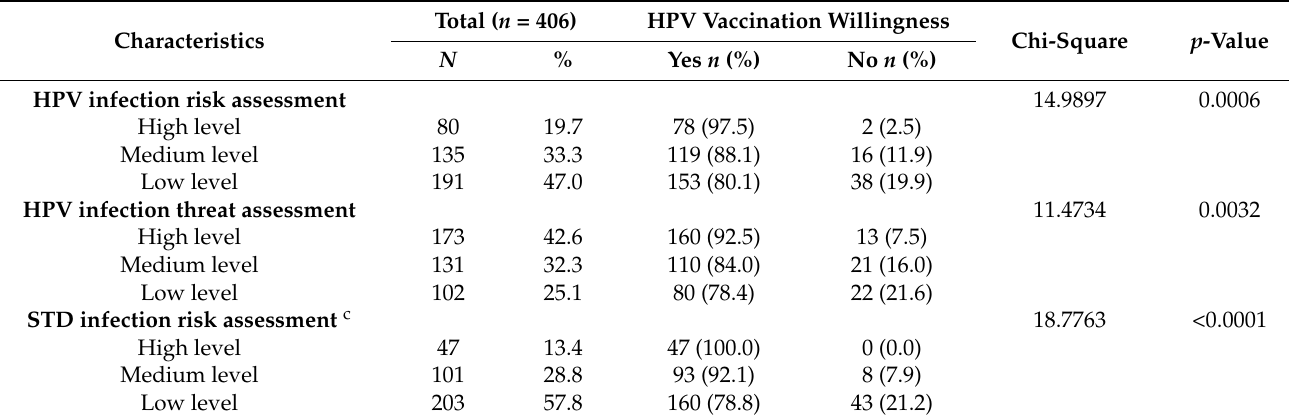
Table 3. Relationship between risk perception and HPV vaccination willingness.